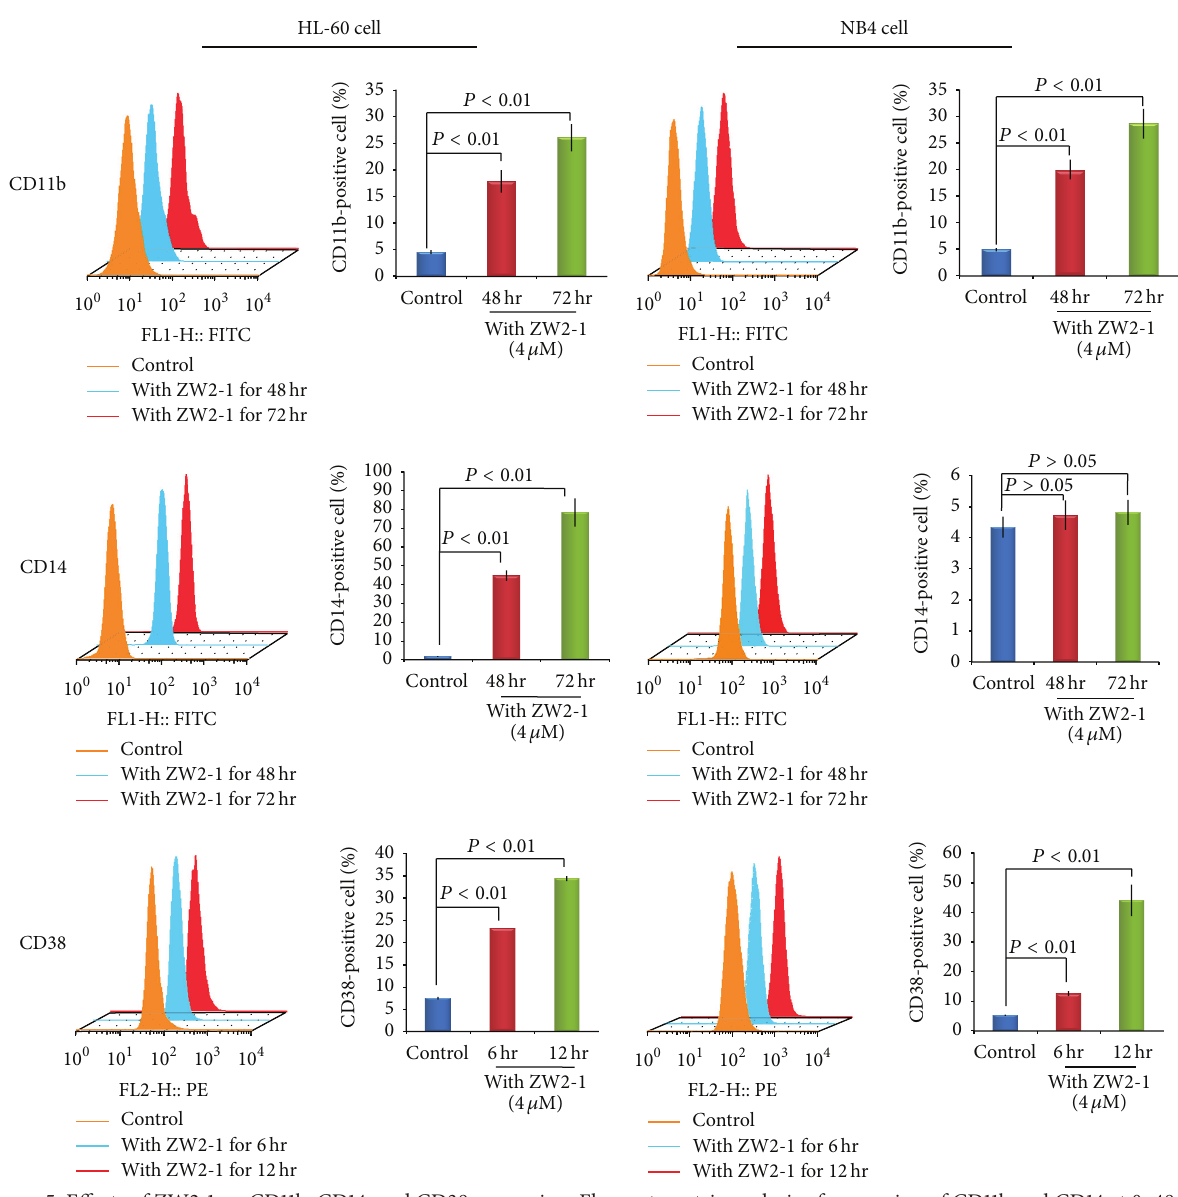
Figure 5: Effects of ZW2-1 on CD11b, CD14, and CD38 expression. Flow cytometric analysis of expression of CD11b and CD14 at 0, 48, and 72 hr after treatment with ZW2-1, respectively, and expression of CD38 at 0, 6, and 12hr after treatment with ZW2-1. To measure the percent positive signal, control group was set to exclude about 95% of the live cell population peak. All experiments are presented as mean ± SD of three independent experiments performed in